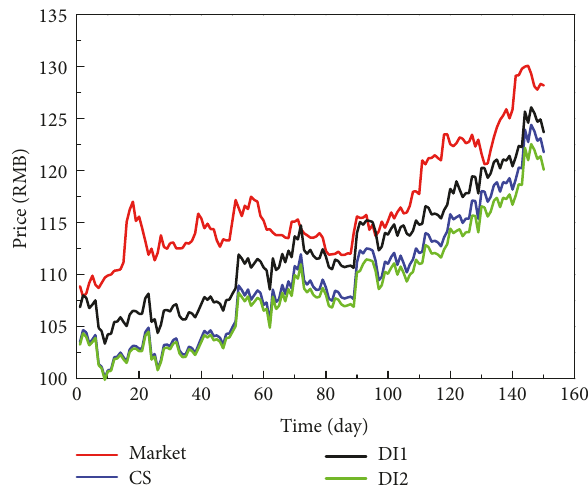
Figure 2: Comparison of the market prices and the theoretical prices of XIG convertible bond calculated by CS method and DI method with supposition that a default may occur only on the maturity date (DI1), and prior to or on the maturity (DI2).